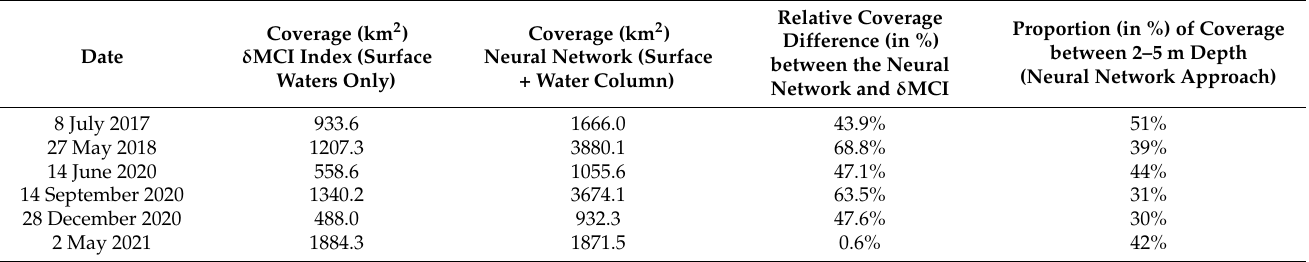
Table 3. Comparison of the Sargassum coverage (in km 2 ) estimated from the neural network and the δ MCI approaches for the OLCI image dataset.